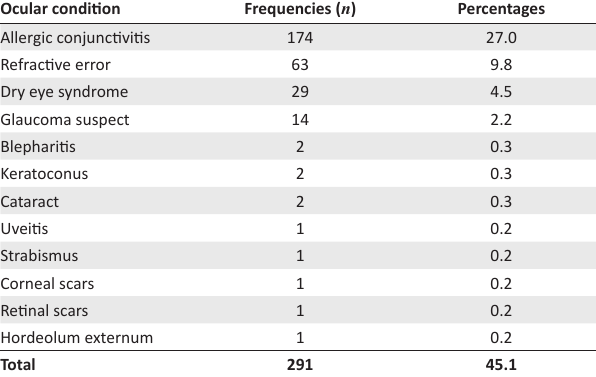
TABLE 3: Ocular conditions shown with frequencies and percentages. Ocular